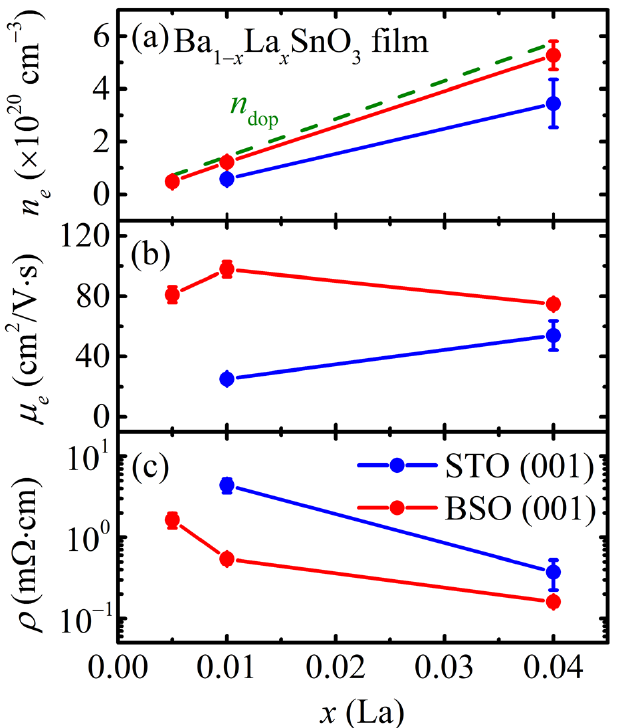
Figure 3. ( a ) Electron concentration ( n e ), ( b ) electron mobility ( µ e ), and ( c ) resistivity ( ρ ) of the Ba 1 − x La x SnO 3 films grown on BSO (001) (red solid symbols) and STO (001) (blue solid symbols) substrates. A green dotted line in ( a ) indicates a nominal dopant concentration ( n dop ) expected from the fully activated La 3+ dopant.